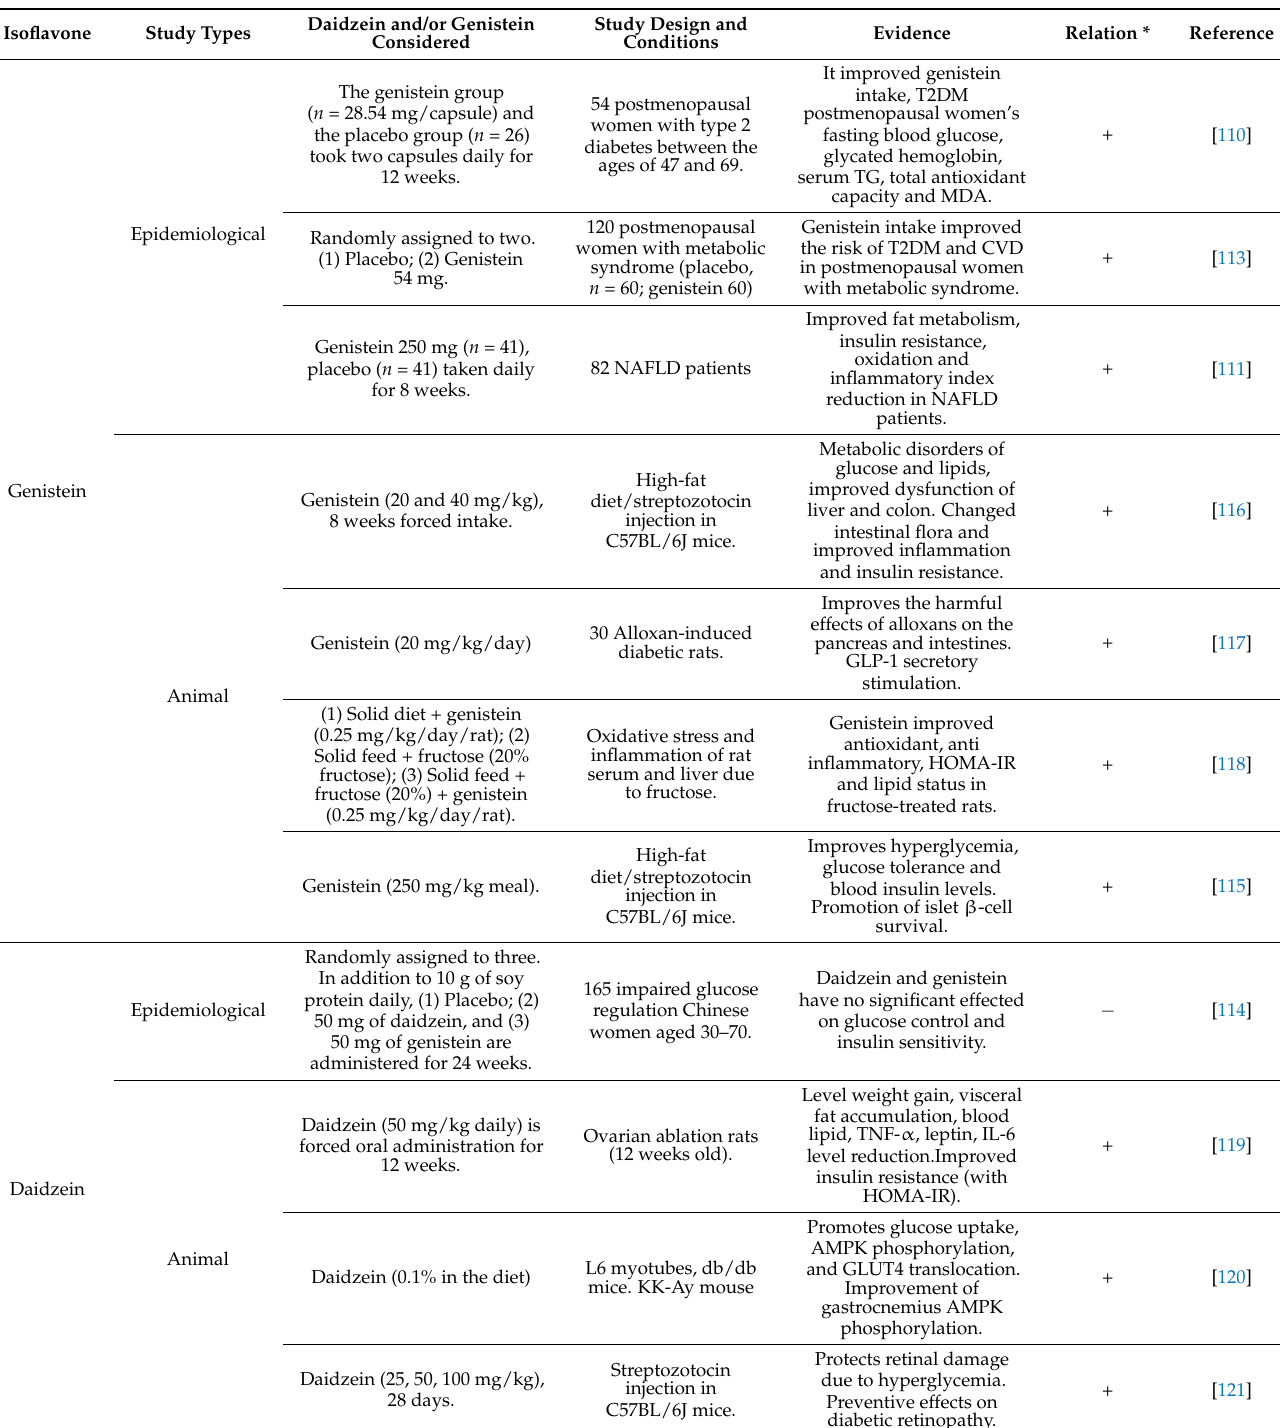
Table 3. Diabetes ameliorating effects of daidzein and genistein reported in epidemiological and animal studies.